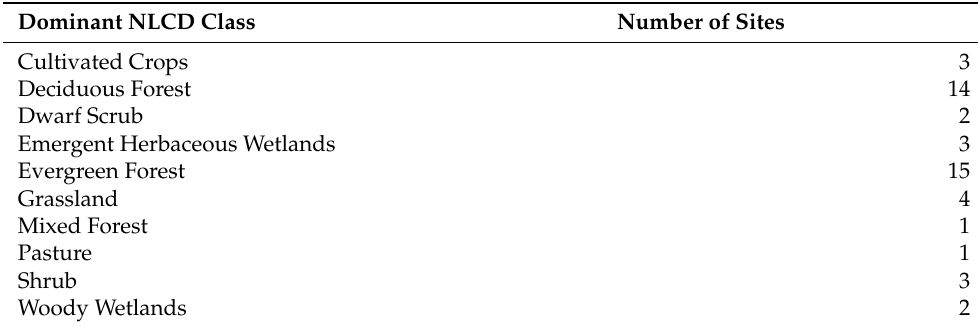
Table 7. Number of NEON sites across the CONUS classified by their dominant NLCD 2016 land cover type.